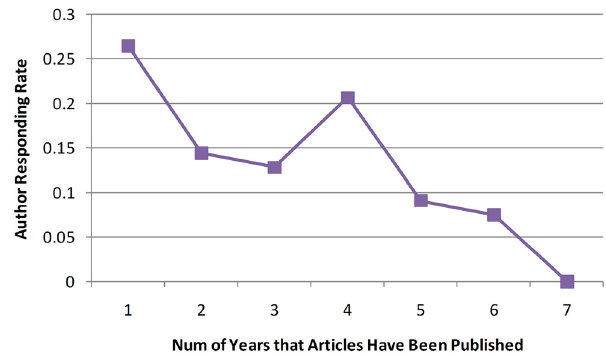
Figure 1. Author’s responding rate as a function of number of years that articles have been published. For example, ‘‘1’’ indicates that articles were published in 2009 and ‘‘7’’ indicates that articles were published in